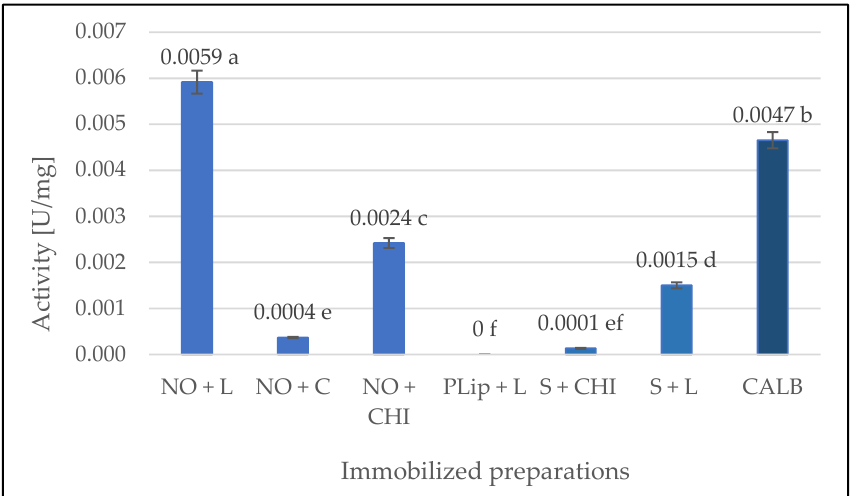
Figure 4. The hydrolytic activity of immobilized preparations: S + CHI: crude enzyme solution of Y. lipolytica immobilized on chitosan powder; S + L: crude enzyme solution of Y. lipolytica immobilized on Lewatit VP OC 1600; PLip + L: purified lipase from the supernatant of Y. lipolytica immobilized on Lewatit VP OC 1600; NO + L: liquid lipase Novozym 51032 immobilized on Lewatit VP OC 1600; NO + C: liquid lipase Novozym 51032 immobilized on coffee grounds; NO + CHI: liquid lipase Novozym 51032 immobilized on chitosan powder; CALB: immobilized lipase B from Candida antarctica as a reference. Means with the same capital letter (a, b, c, d, e, f) did not differ significantly (α = 0.05).